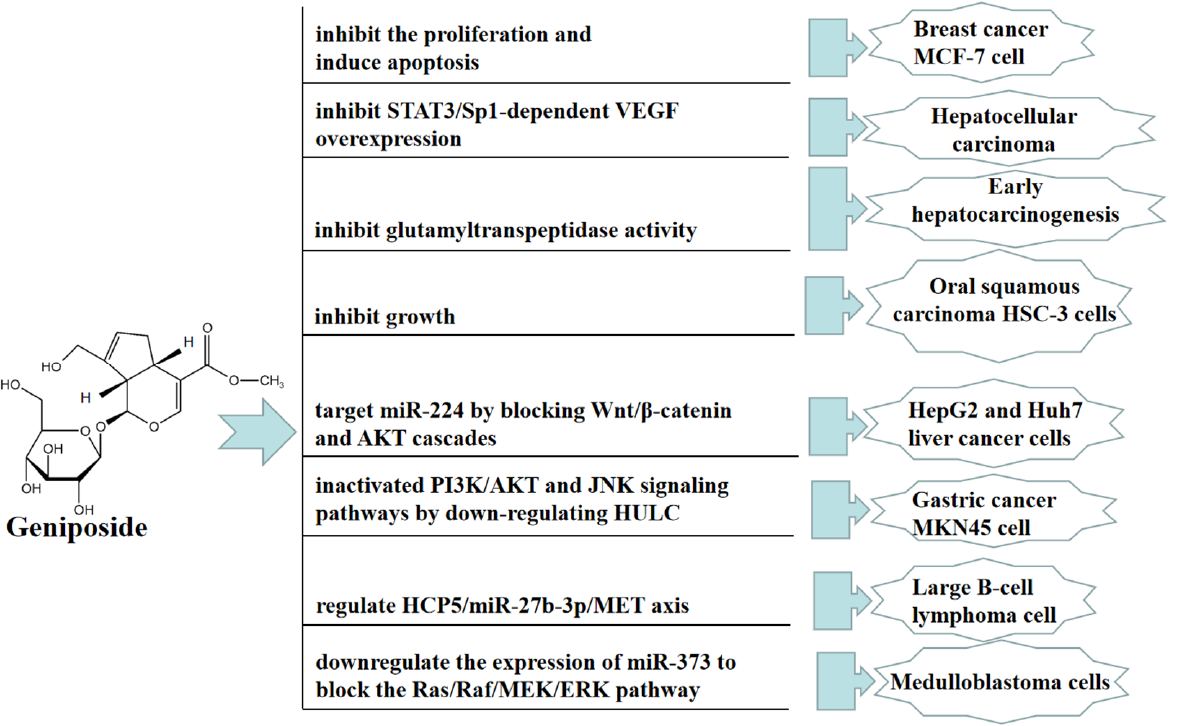
Figure 4. A summary of mechanisms of geniposide on tumors.